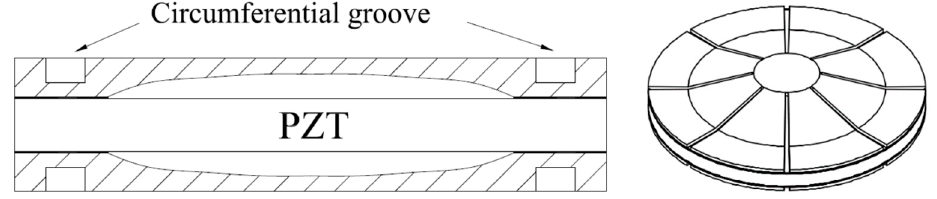
Figure 16. Structure diagrams of cymbal with circumferential groove ( left ) and radial groove ( right